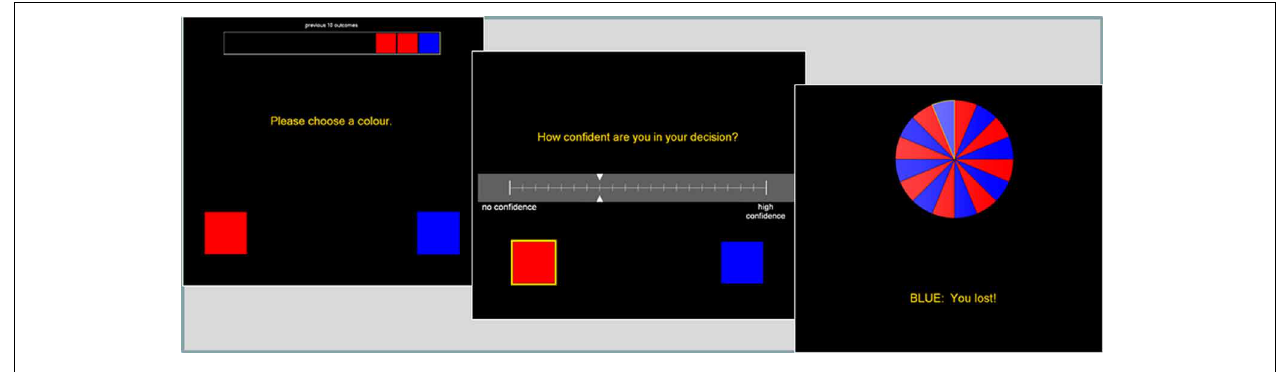
FIGURE 2 | The roulette task presented a color choice (red or blue) on each trial, followed by a confidence rating. The roulette wheel then spun, and the outcome and feedback were